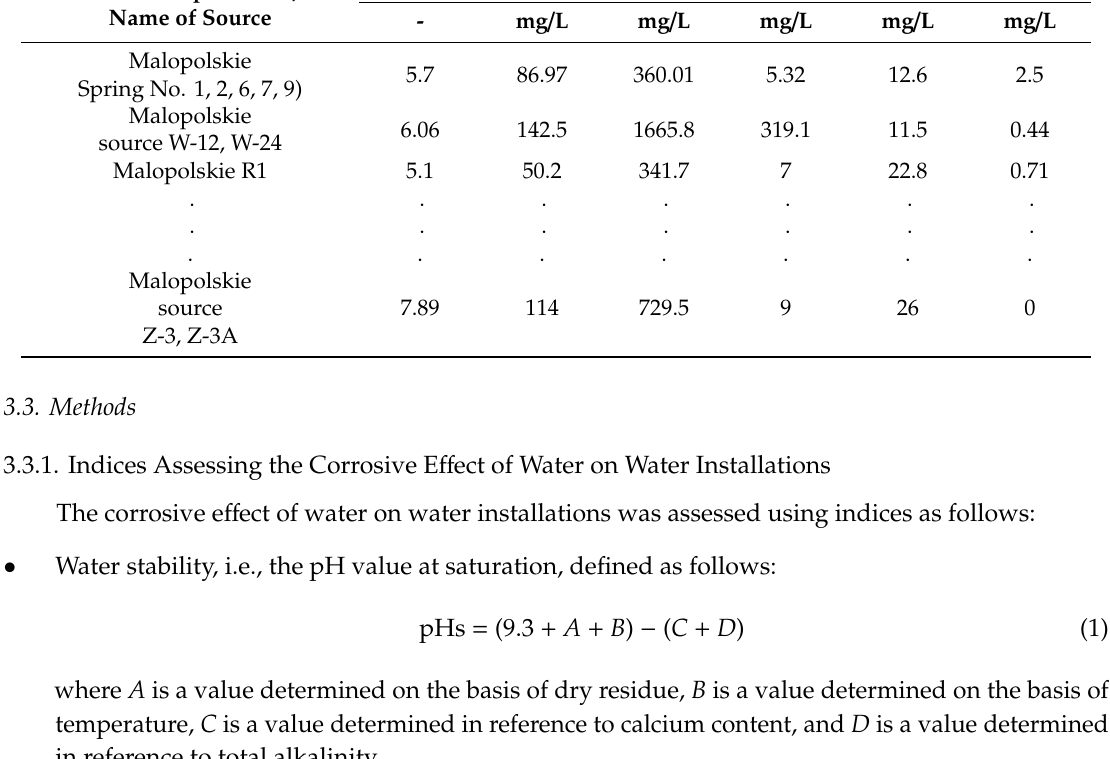
Table 1. Properties of selected bottled mineral waters—some results from all of the analyzed waters. Place of Exploitation / Name of